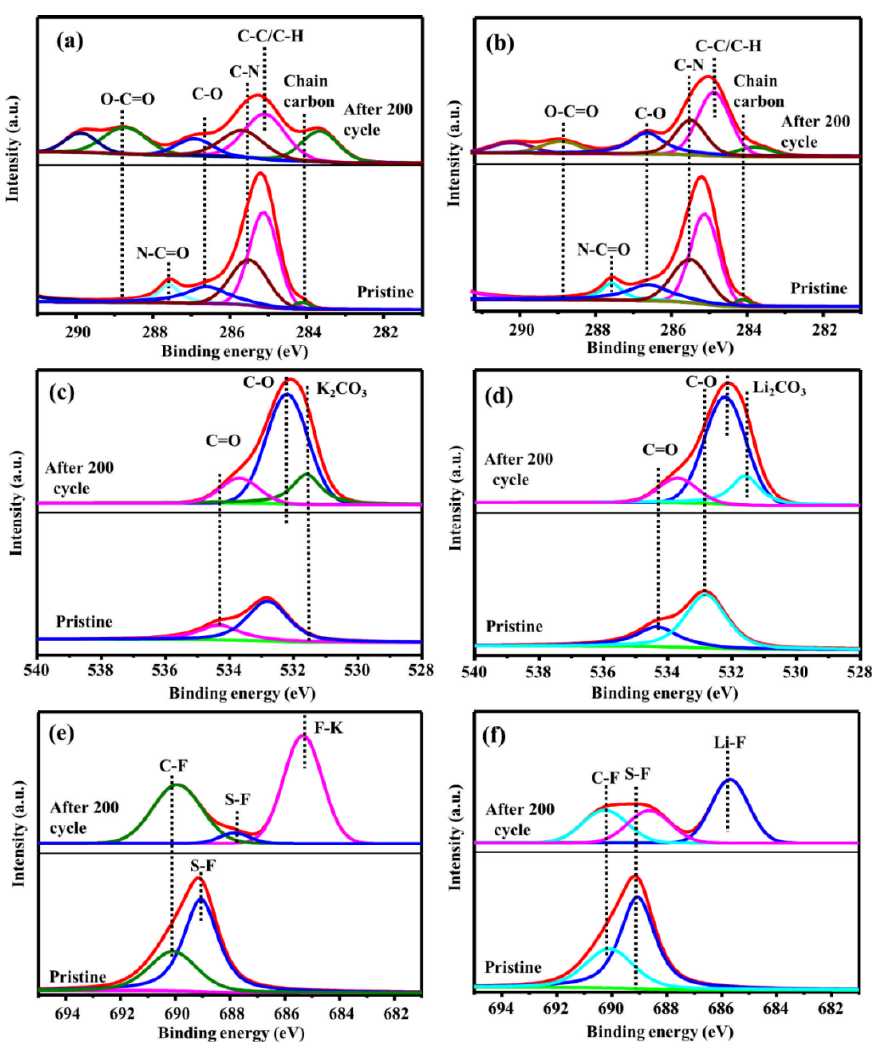
Figure 7. High − resolution ( a , b ) C 1s, ( c , d ) O 1s, and ( e , f ) F 1s XPS spectra of ( a , c , e ) K − MA_KFSI and ( b , d , f ) K − MA_LiFSI electrodes, recorded before and after 200 cycles. The intensity of the signals for the organic species in the C 1s spectrum of the de- doped K-MA_KFSI electrode (Figure S4b) decreased when compared with those of the K-MA_LiFSI electrode (Figure S4d), indicating that the SEI formed covering the former electrode featured unstable organic species, relative to those formed on the latter. The stronger and higher-intensity signal for residual KFSI in K-MA_KFSI (Figure S4e) on a discharged electrode surface, relative to that of K-MA_LiFSI (Figure S4f), suggests that a thicker SEI layer formed for the former than that for the latter. In addition, the intensity of the peak for LiF in the SEI was higher than that of KF, revealing that the presence of inorganic-rich LiF in the SEI layer protected the K-MA_LiFSI electrode. Figure S3 demonstrate that the ex-situ FTIR spectra of K-MA_KFSI and K-MA_LiFSI electrodes in pristine, charging, and discharging states. In Figure S3a, the O=C − N intensity peak of the K-MA_KFSI pristine at 1562 cm − 1 is weaken and broad when charged to 0 V and reappeared after discharged to 3 V. This indicates that carbonyl of the primary amine participated in charge-discharge reaction. However, in Figure S3b the K-MA_LiFSI pristine electrode of intensity peaks C=O at 1676 cm − 1 and O=C − N at 1562 cm − 1